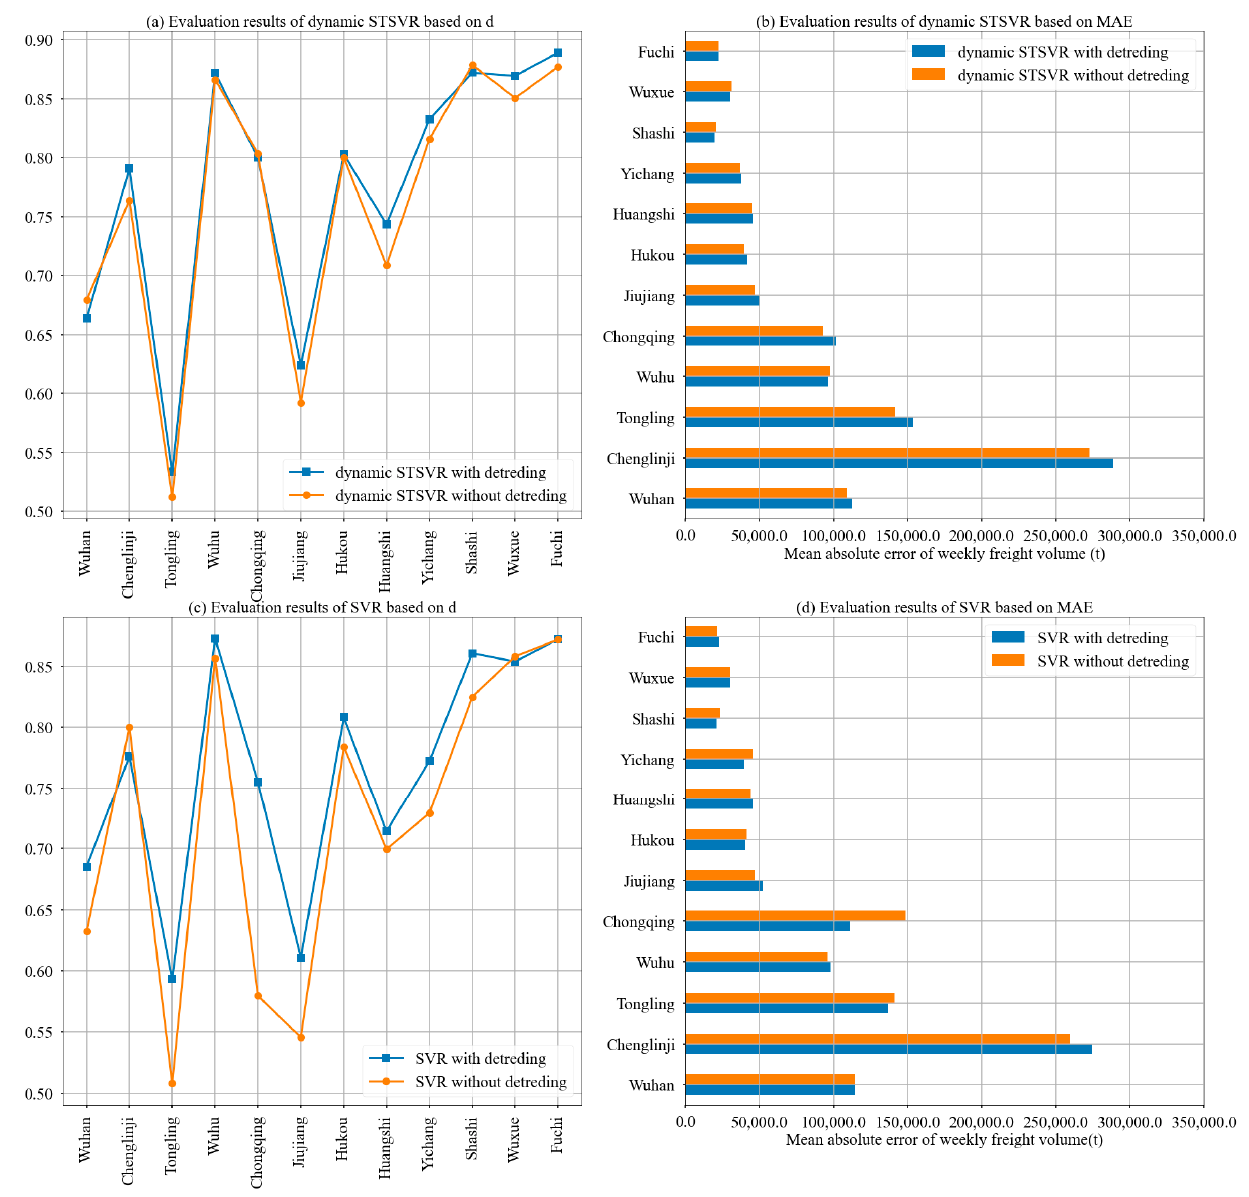
Figure 12. Evaluation results of predictions based on time series with and without stationary processing.